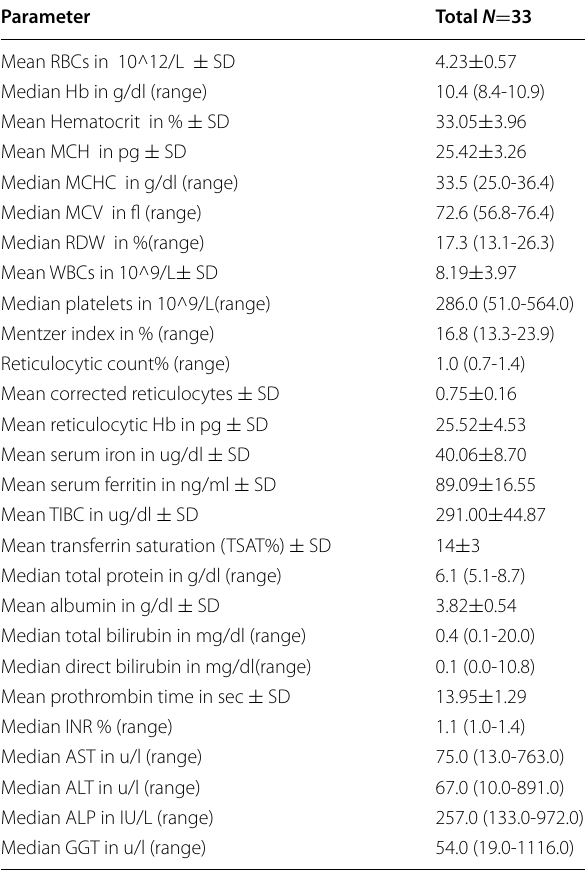
Table 2 Hematological and biochemical parameters of all